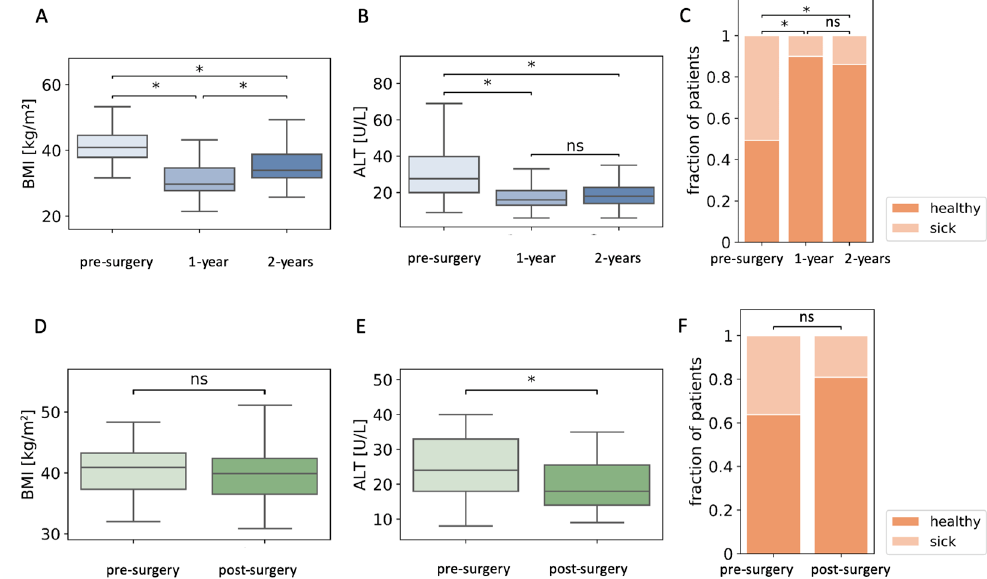
Figure 3. Alanine aminotransferase (ALT) levels are reduced in patients who regain lost weight. ( A ) Body mass index (BMI) of patients who regained at least 25% excess weight loss during the second year after surgery. ( B ) ALT levels in the same group of patients. ( C ) Fraction of patients with abnormal levels of ALT pre-surgery, and one and two years after surgery. ( D ) BMI of patients that did not lose weight two years after surgery. ( E ) Pre- and two-year post-surgery ALT levels of the same group of patients. ( F ) The fraction of patients that did not lose weight that had abnormal ALT levels before surgery and two years after surgery; n = 150 ( A – C ); n = 47 ( D – F ); ns, non-significant; * p < 0.05 by Kruskal–Wallis and Mann–Whitney post-hoc U test ( A , B ), Mann–Whitney U test ( D , E ), or χ 2 test ( C , F ), followed by Bonferroni correction for all tests.